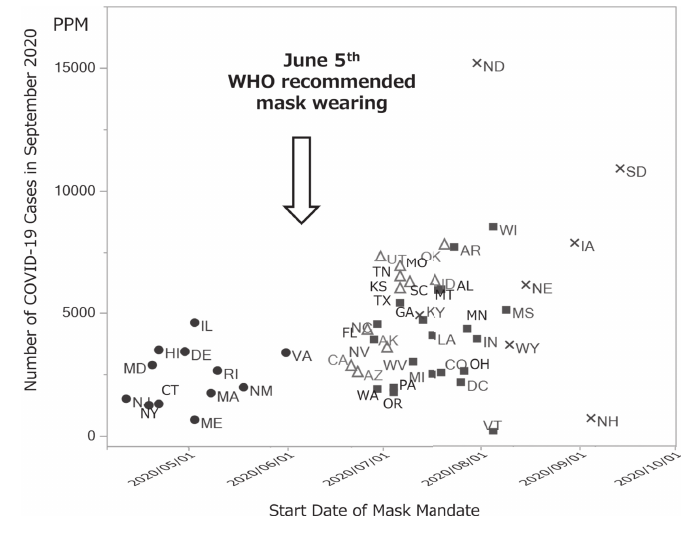
Figure 2. Number of